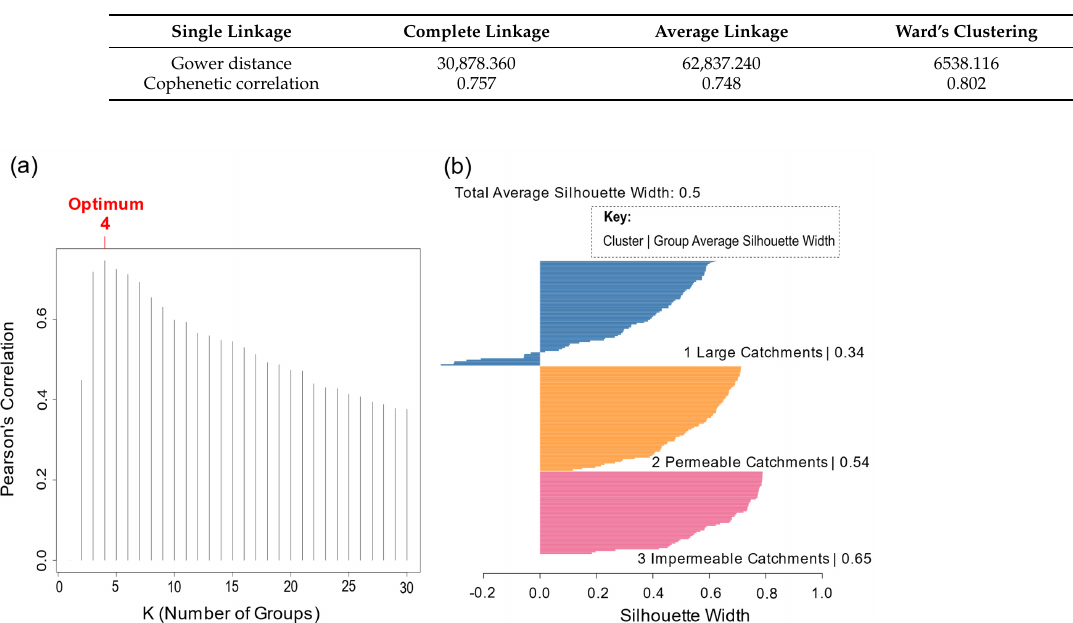
Table 4. Gower distance and cophenetic correlation results for all four hierarchical clustering methods for comparison. A high cophenetic correlation indicates a strong relationship between the distance matrix and the cophenetic matrix describing the dendrogram split where each point is clustered differently. A lower Gower distance indicates an acceptable clustering algorithm.